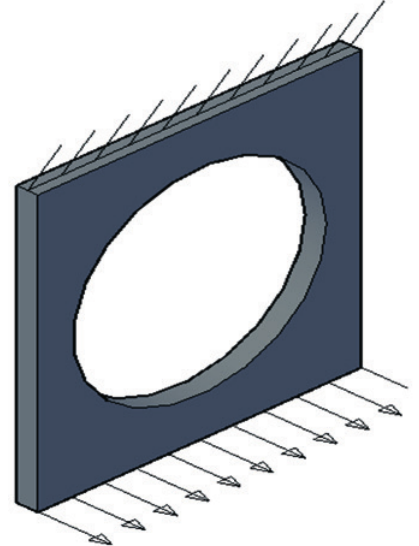
Figura 8 Modelo simplificado para formulação